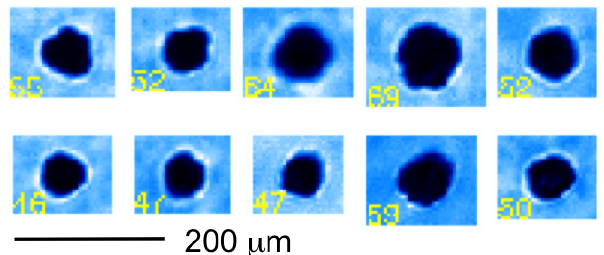
Fig. 1. Example small ice crystals imaged by the CPI during TWP-ICE. The 200µm scale bar embedded left bottom corner. Maximum dimension is indicated within each image.